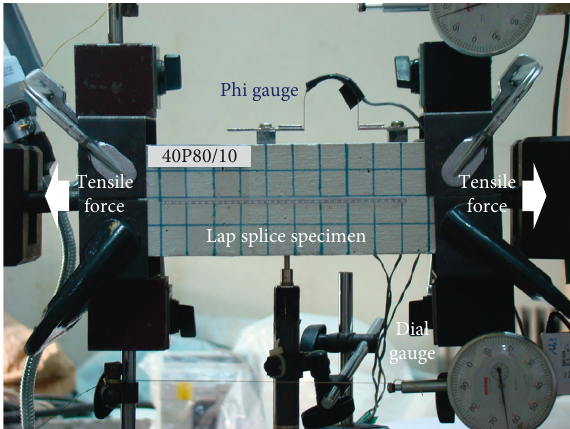
Figure 2: Test setup of spliced specimens in the direct